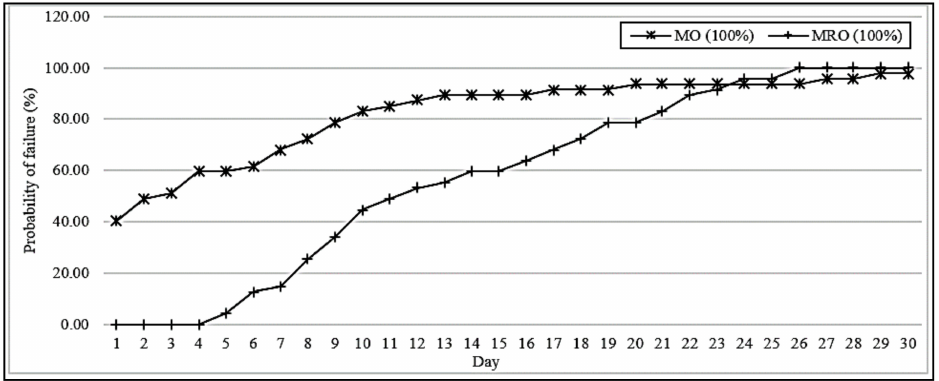
Figure 5. Showing the endurance of breakdown voltage and probability of failure of MRO and MO for 30